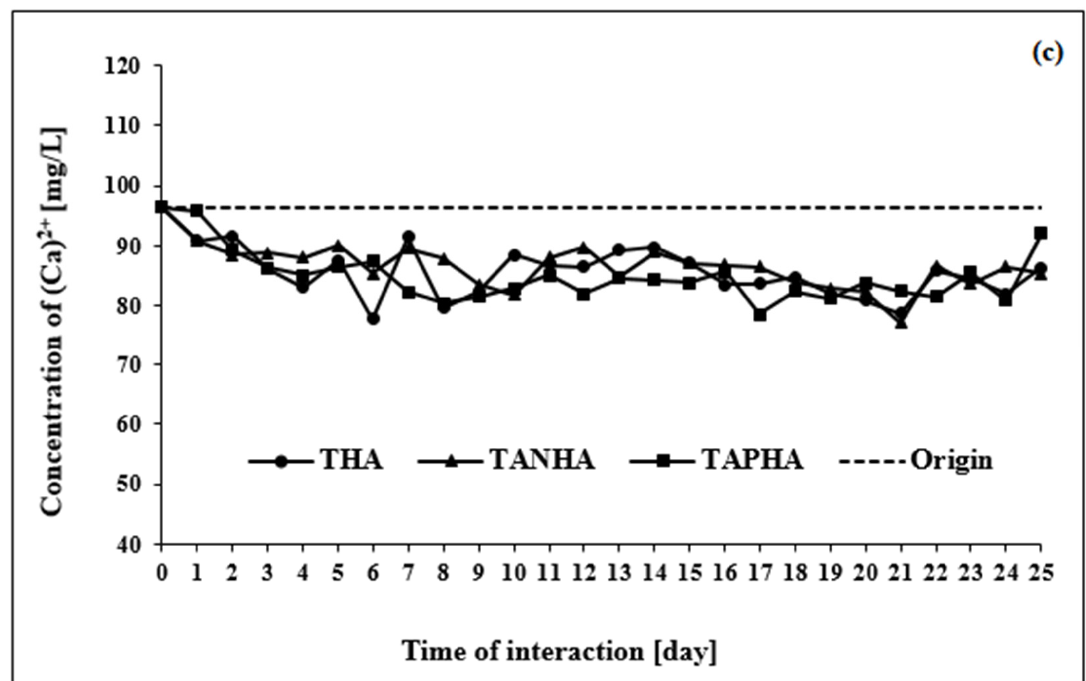
Figure 4. Diagrams of: ( a ) pH value, ( b ) phosphate concentration, and ( c ) calcium concentration in MSBF during the static-dynamic in vitro test.